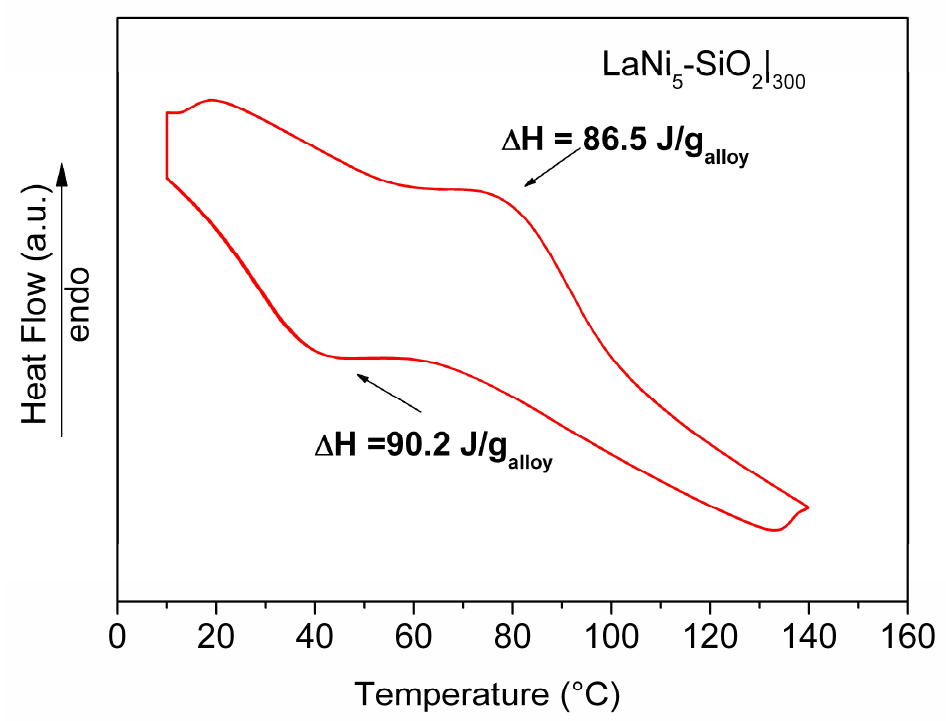
Figure 10. HPDSC analysis of the consolidated LaNi trace consists of perfectly overlapped 4 run